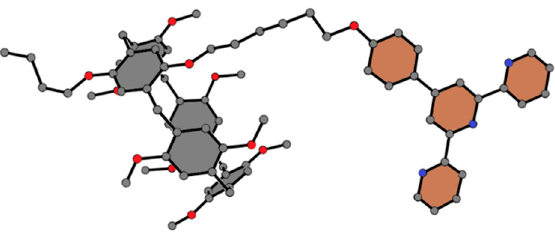
Figure 1. Single crystal structure of TP5 . Carbon atoms are represented in gray, oxygen atoms in red and nitrogen atoms in purple. Hydrogen atoms were omitted for clarity.